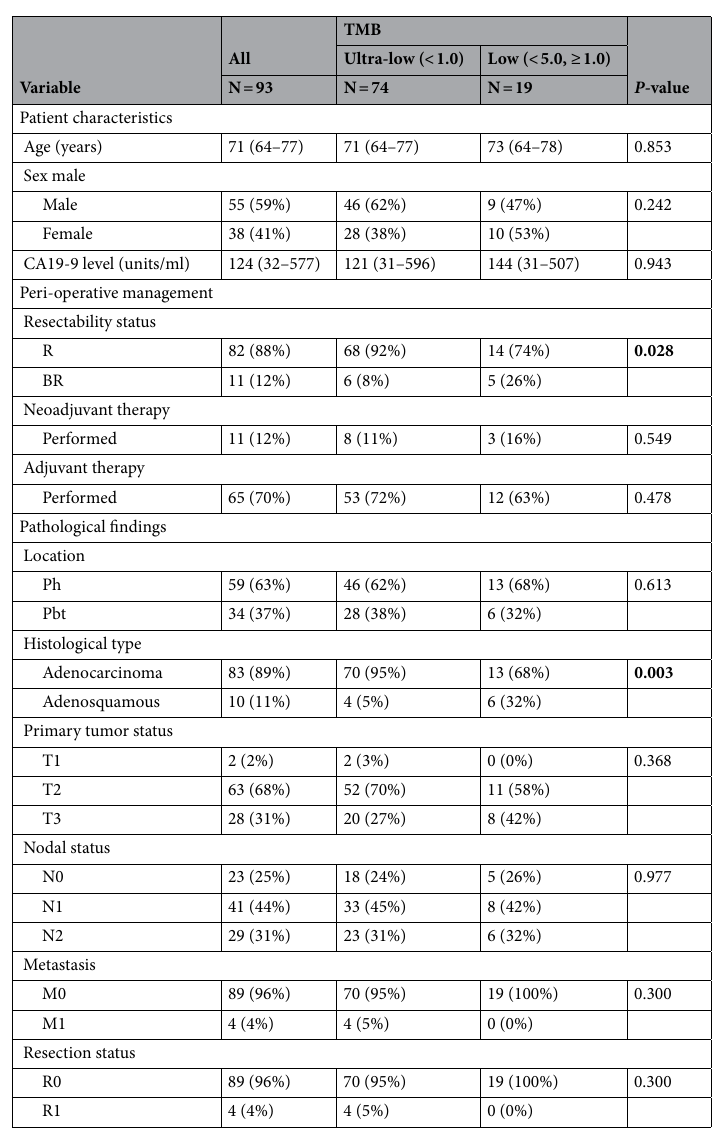
Table 1. Clinical correlates according to the TMB status. BR borderline resectable, R resectable, Ph pancreatic head, Pbt pancreatic body and tail, TMB tumor mutation burden. Significant values are in